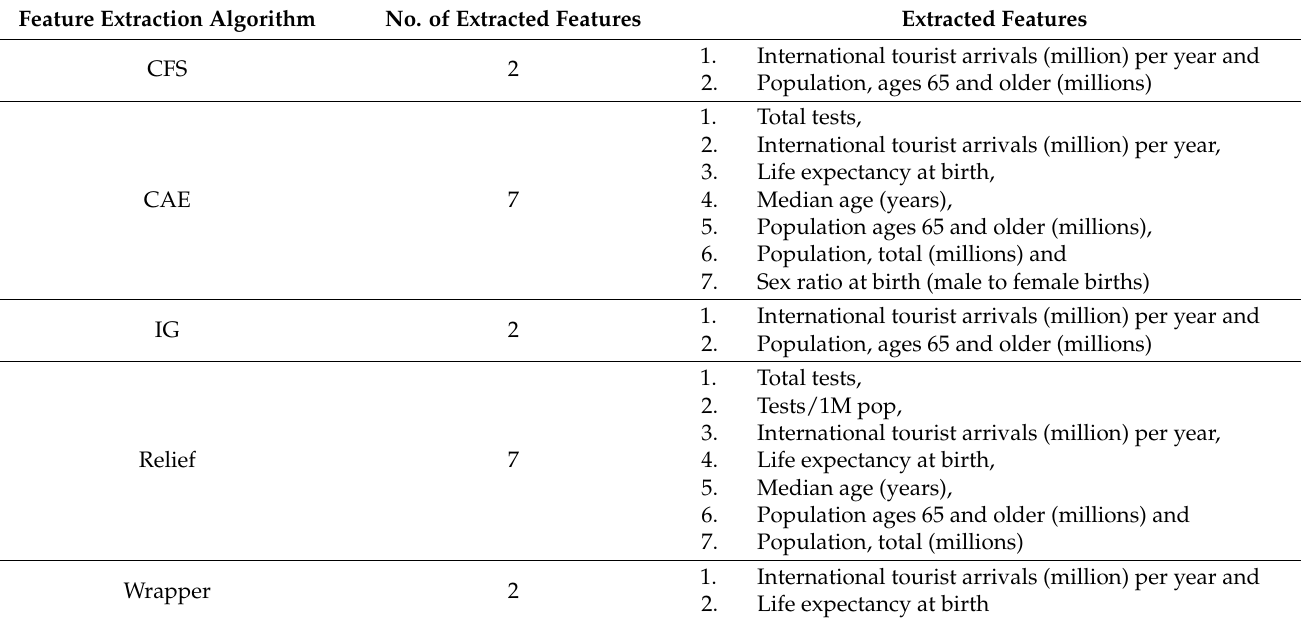
Table 14. The ranked features of the feature extraction algorithms to predict the total recovery cases.